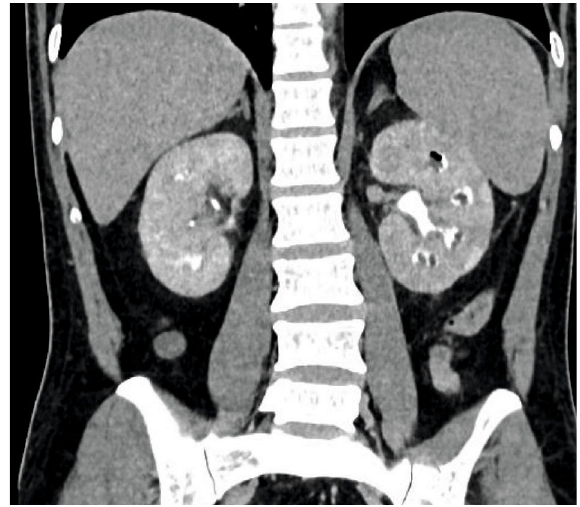
Figure 3: Renal papillary necrosis in the left kidney on delayed contrast CT scan on the 5 th postoperative day. Coronal reconstruction. Air in the upper caliceal system represents prior